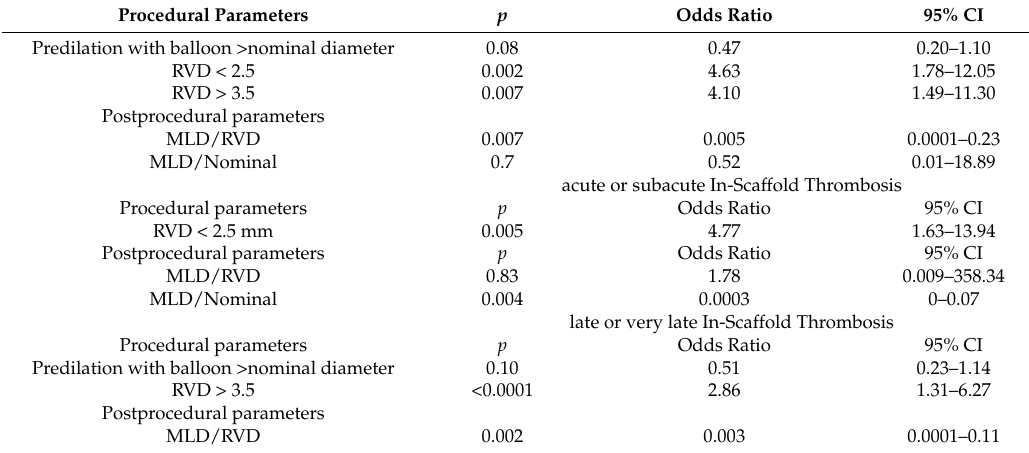
Table 1. Multivariate Cox regression analysis of the individual procedural and postprocedural characteristics with respect to scaffold